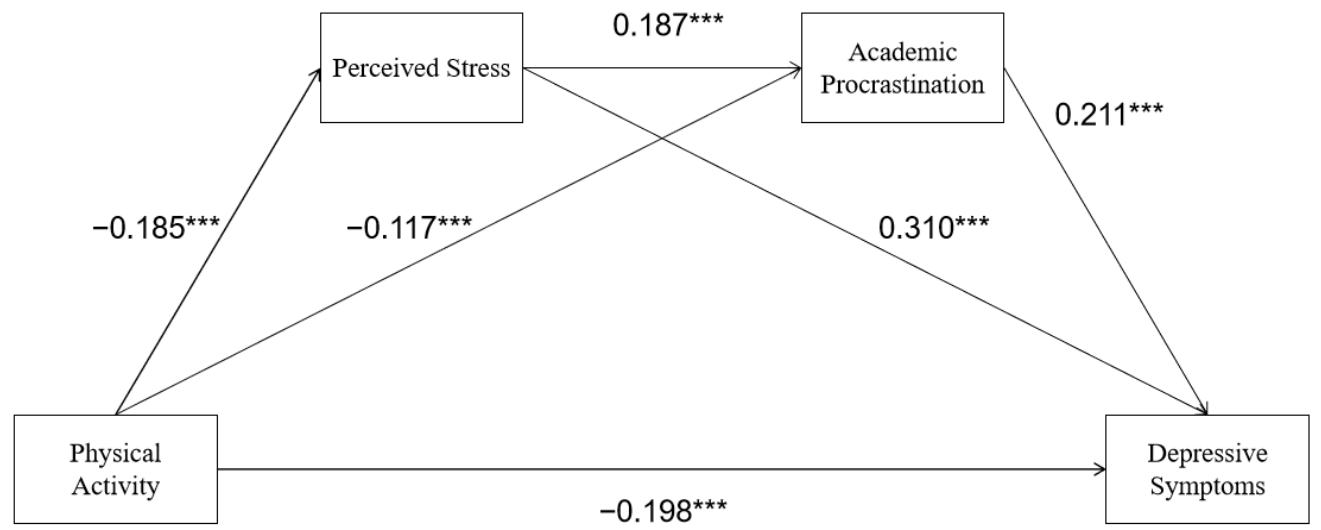
Figure 2. The chain mediating effect of perceived stress and depressive symptoms. *** p < 0.001.